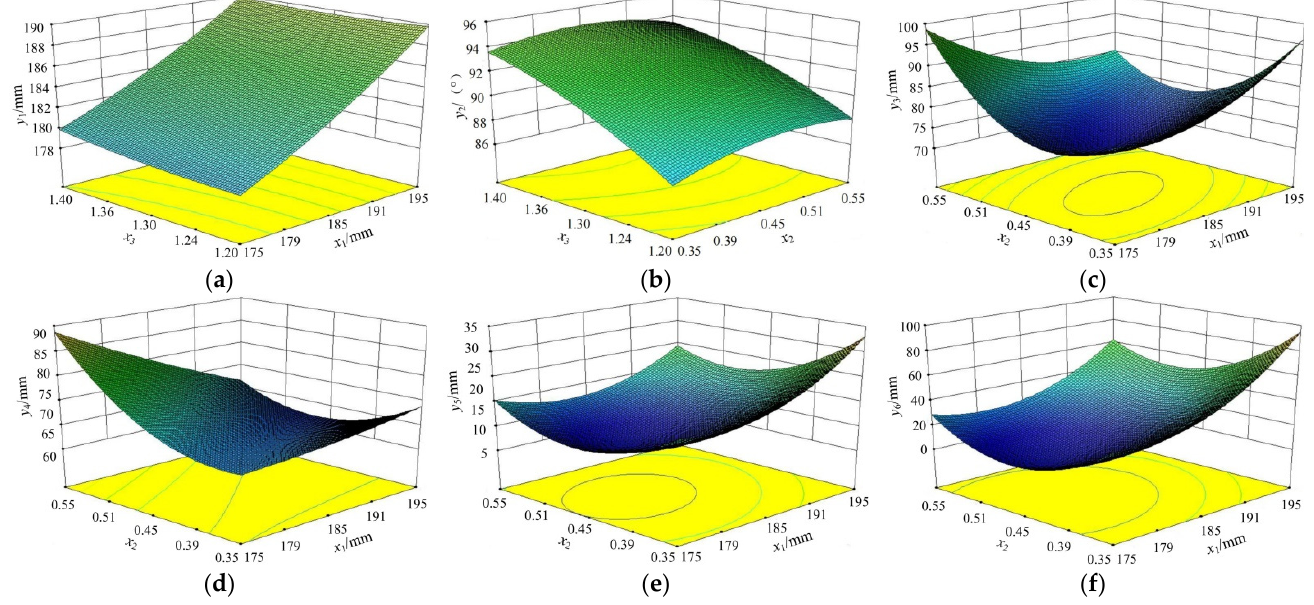
Figure 4. Response surface of factor to test index: ( a ) influence of crank’s length and non-circular gear deformation coefficient on the depth of cavitation at the zero level of other factors; ( b ) influence of the deformation coefficient and the eccentricity for the non-circular gear on the vertical angle of cavitation at the zero level of other factors; ( c ) influence of crank’s length and non-circular gear eccentricity on the maximum diameter of cavitation at the zero level of other factors; ( d ) influence of crank’s length and non-circular gear eccentricity on the minimum diameter of cavitation at the zero level of other factors; ( e ) influence of crank’s length and non-circular gear eccentricity on the difference between the maximum and minimum diameter of cavitation at the zero level of the other factors; ( f ) influence of the length for the crank and the eccentricity for the non-circular gear on the variance in diameters for cavitation at the zero level of other